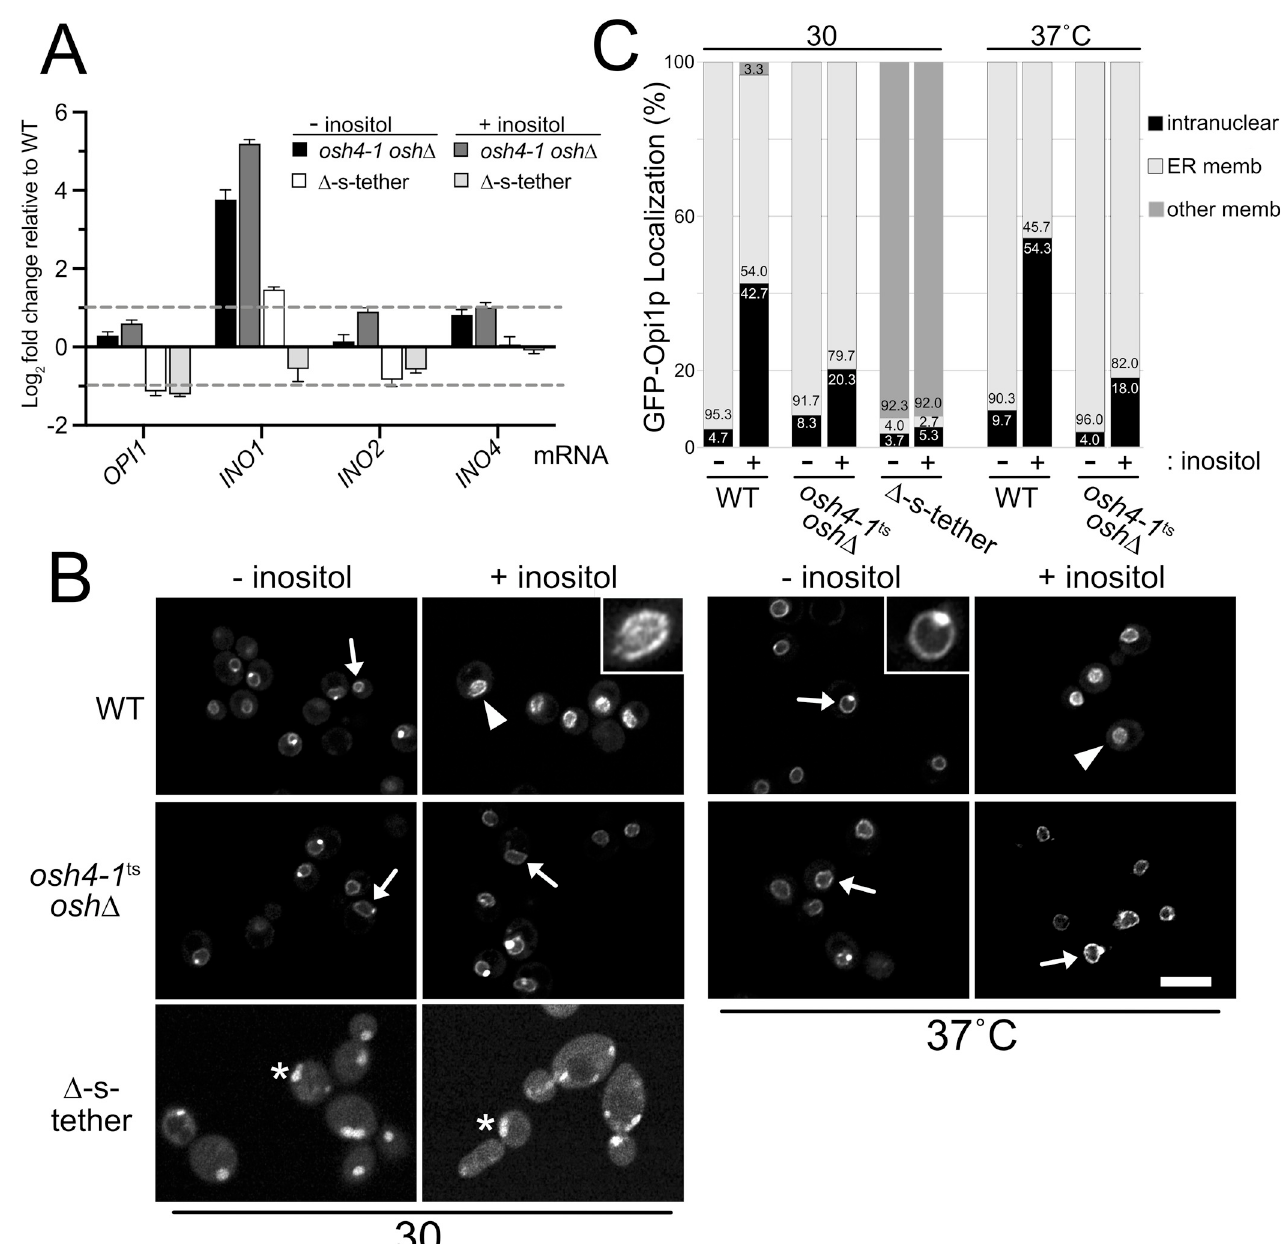
Fig 8. Phospholipid gene dysregulation due to Opi1p nuclear translocation defects. (A) Relative to WT (SEY6210), transcript abundance of OPI1 , INO1 , INO2 and INO4 in Δ -s-tether (CBY5838) cells cultured with or without 75 μ M inositol at 30˚C for 1 h. Relative mRNA levels of these phospholipid regulatory genes were also determined in osh4-1 ts osh Δ (CBY926) cells at 37˚C for 1 h, with or without inositol. (B) Representative confocal fluorescent microscopy images of WT, osh4-1 ts osh Δ , and Δ -s-tether cells expressing GFP-Opi1p (pRS416-PHO5-GFP-OPI1) grown with or without 300 μ M inositol at the growth temperatures indicated. Arrows indicate examples of GFP-Opi1p at the ER/nuclear membrane, arrowheads indicate intranuclear localization, and asterisks indicate examples of GFP-Opi1p localization distinct from either nuclear ER or intranuclear fluorescence. Inserts show examples of magnified images of nuclear membrane or intranuclear GFP-Opi1p. Scale bar = 5 μ m. (C) Quantification of GFP-Opi1p localization in cells corresponding to panel (B). In response to inositol addition, the percentage of cells with GFP-Opi1p localization in the ER membrane, intranuclear, or other cellular membrane is indicated as shown (n = 300 cells per each strain).